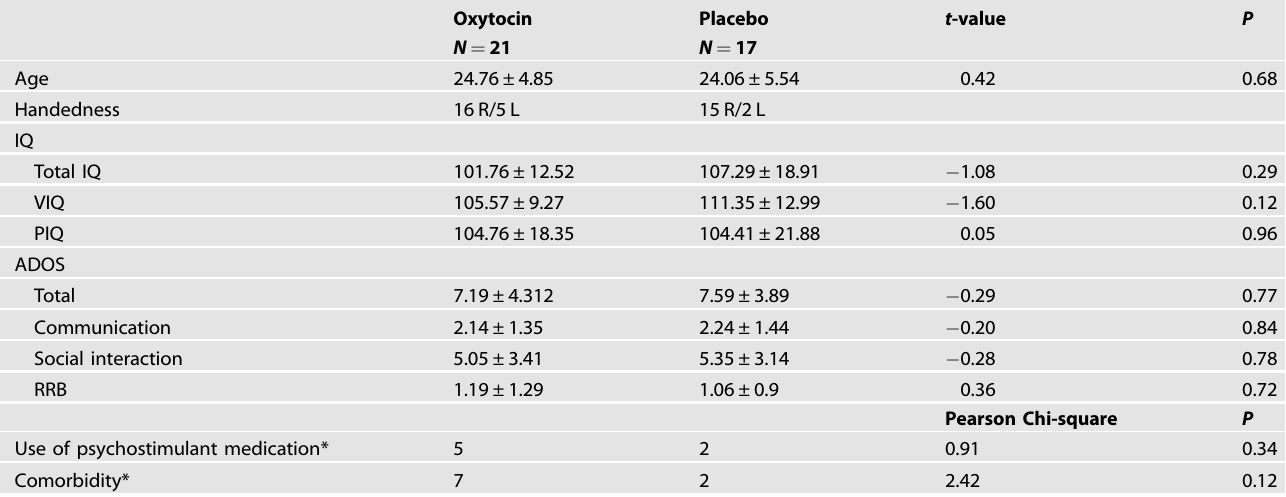
Table 1. Demographic and clinical characteristics of participants randomized to receive oxytocin or